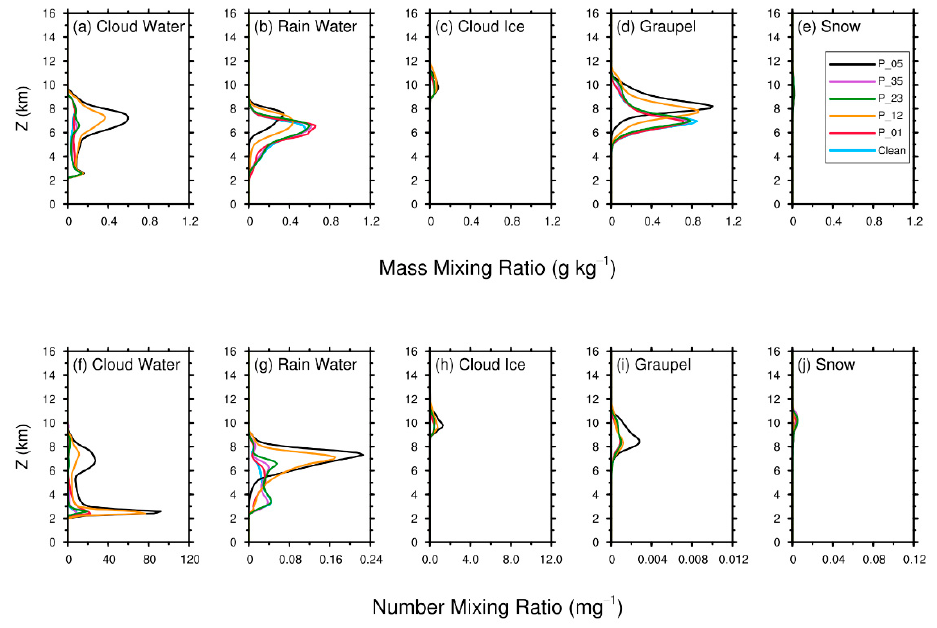
Figure 6. The horizontally averaged vertical profiles of the mass mixing ratios ( upper row ) and number mixing ratios ( bottom row ) of all hydrometeors at 20 min. Hydrometeors including cloud water, rain water, cloud ice, graupel, and snow are shown from left to right respectively. The horizontal average region is a circular area with the center at the domain center and a radius of 10 km (the same as the base of the column region in Figure 4).